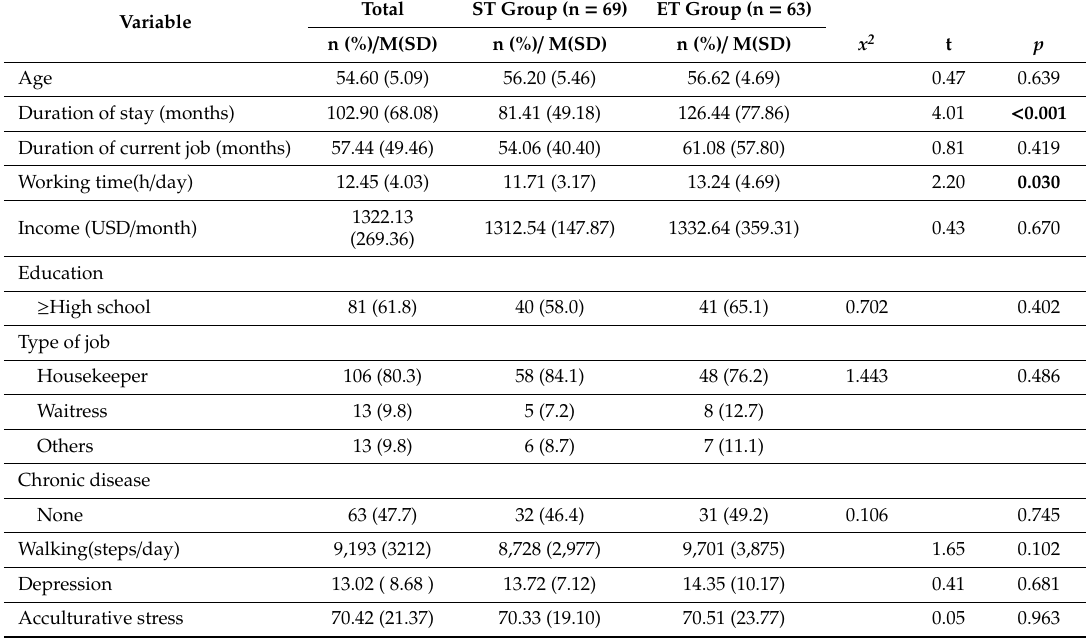
Table 1. Participants’ baseline